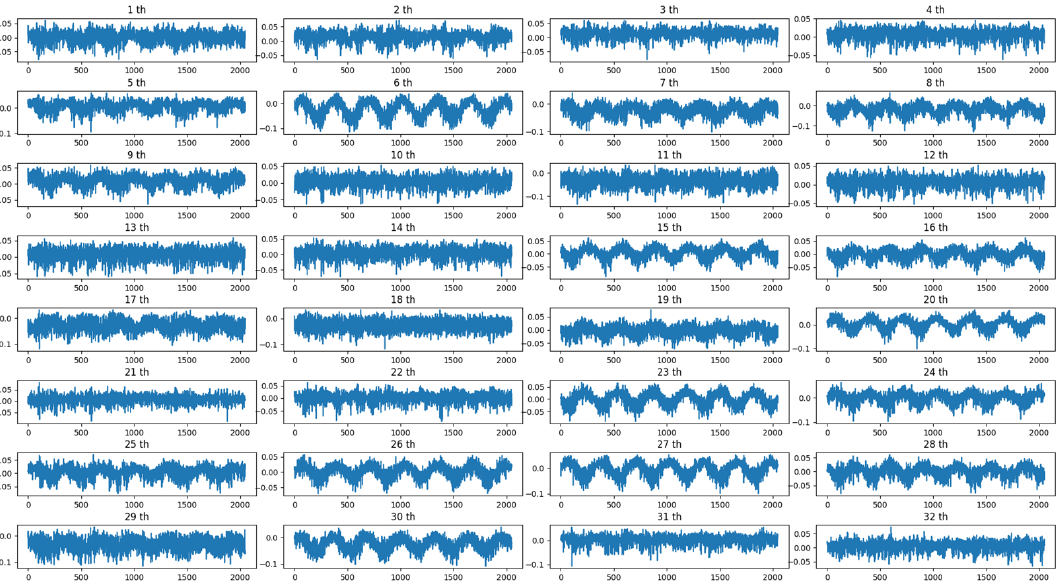
Figure 13. Feature vector output of the first convolution layer.